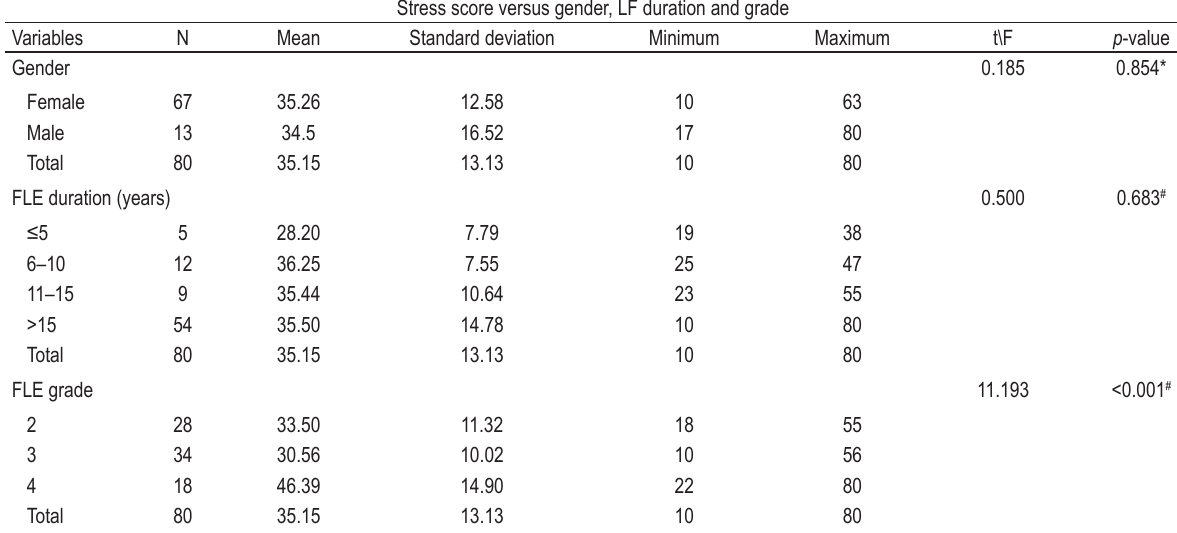
TABLE 4. Comparison of stress score by gender, duration, and grade of filarial lymphoedema